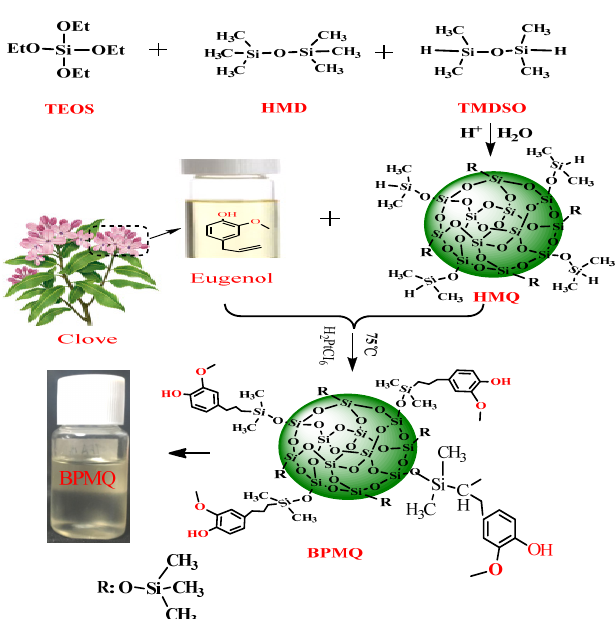
Figure 1. Scheme of synthesis of HMQ and BPMQ (TEOS: tetraethyl orthosilicate; HMD: hexamethyldisiloxane; TMDSO: 1,1,3,3-tetramethyldisiloxane; HMQ: hydrogen containing MQ silicone resin; BPMQ: bio-Phenol MQ Silicone Resin).